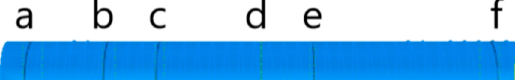
Figure 5. Index segmentation.